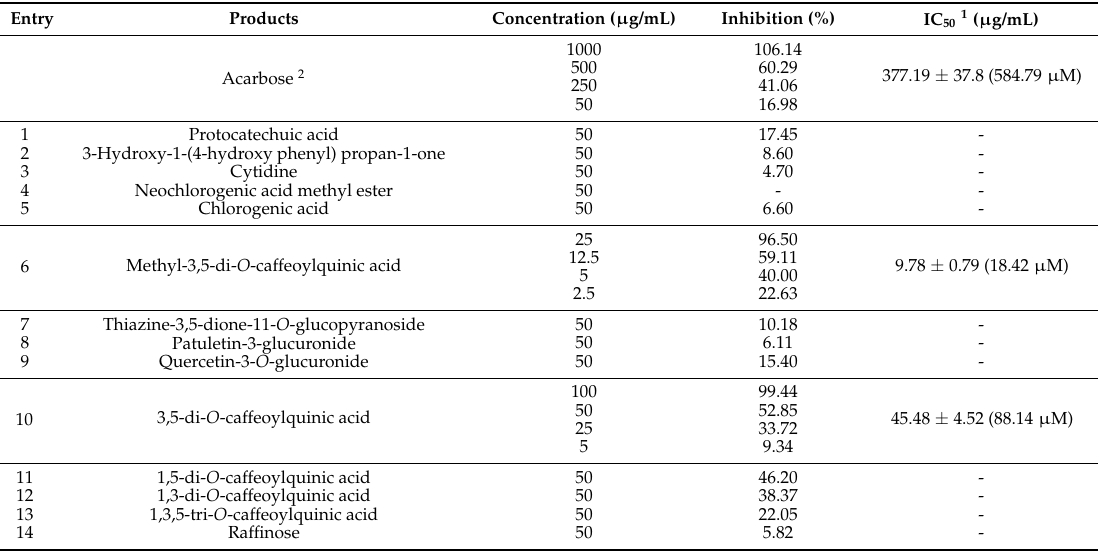
Table 3. Inhibitory effect of isolated compounds from X. strumarium on α -glucosidase.